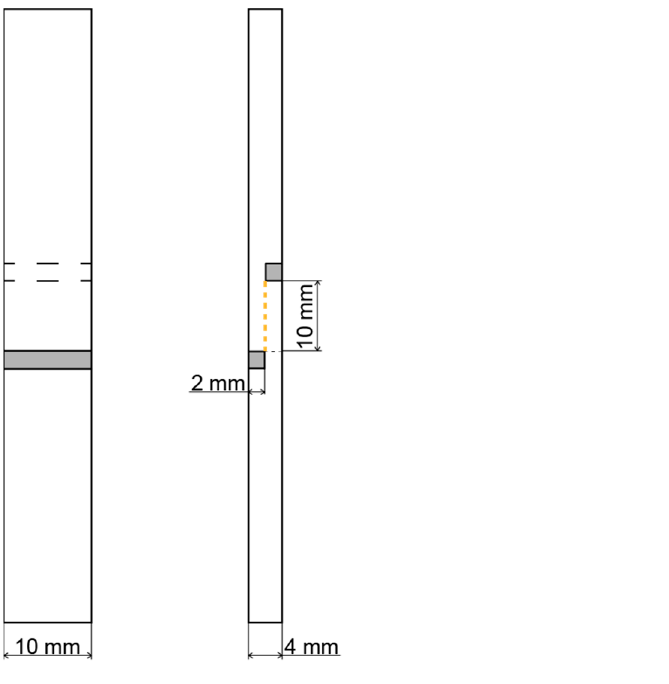
Figure 3. Geometry of samples for interlaminar shear strength tests.